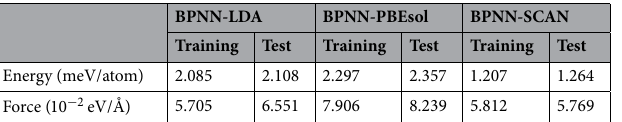
Table 1. RMSE of BPNN-LDA, BPNN-PBEsol and BPNN-SCAN for the training and test